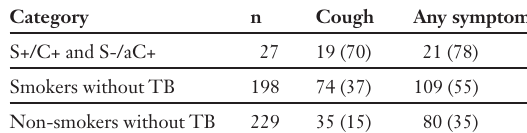
Symptoms among 27 immigrants with doc- umented TB (S+/C+ and S-/C+), 198 smok- ers with normal CXR and 229 non-smokers with normal CXR. Any symptom is a positive answer to at least one of the ques- tions about cough, sputum production, fever, night sweating or weight loss. Ab- solute numbers with % in brackets.